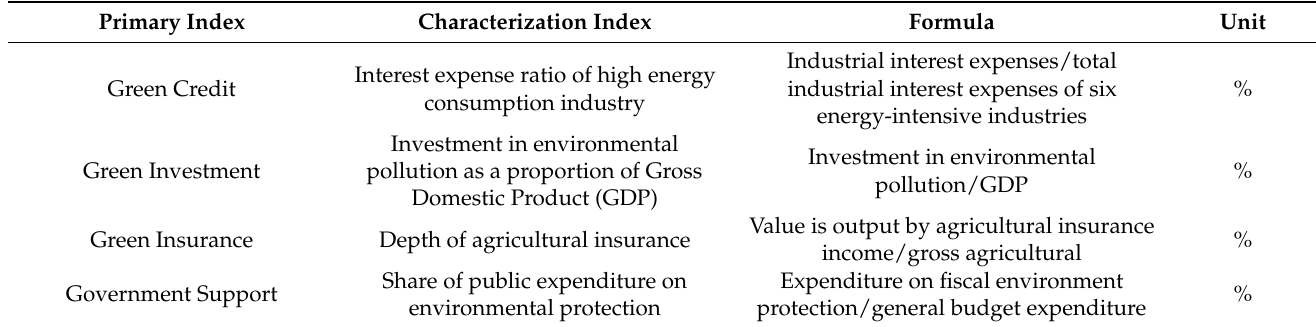
Table 1. Low-carbon and sustainable financing evaluation index system.